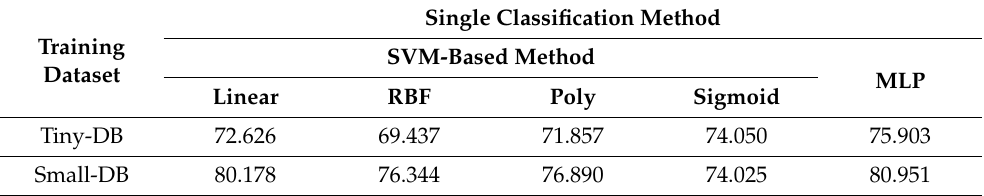
Table 7. Classification performance of SVM and MLP using the BT-Small dataset according to the size of the training data (unit: %).